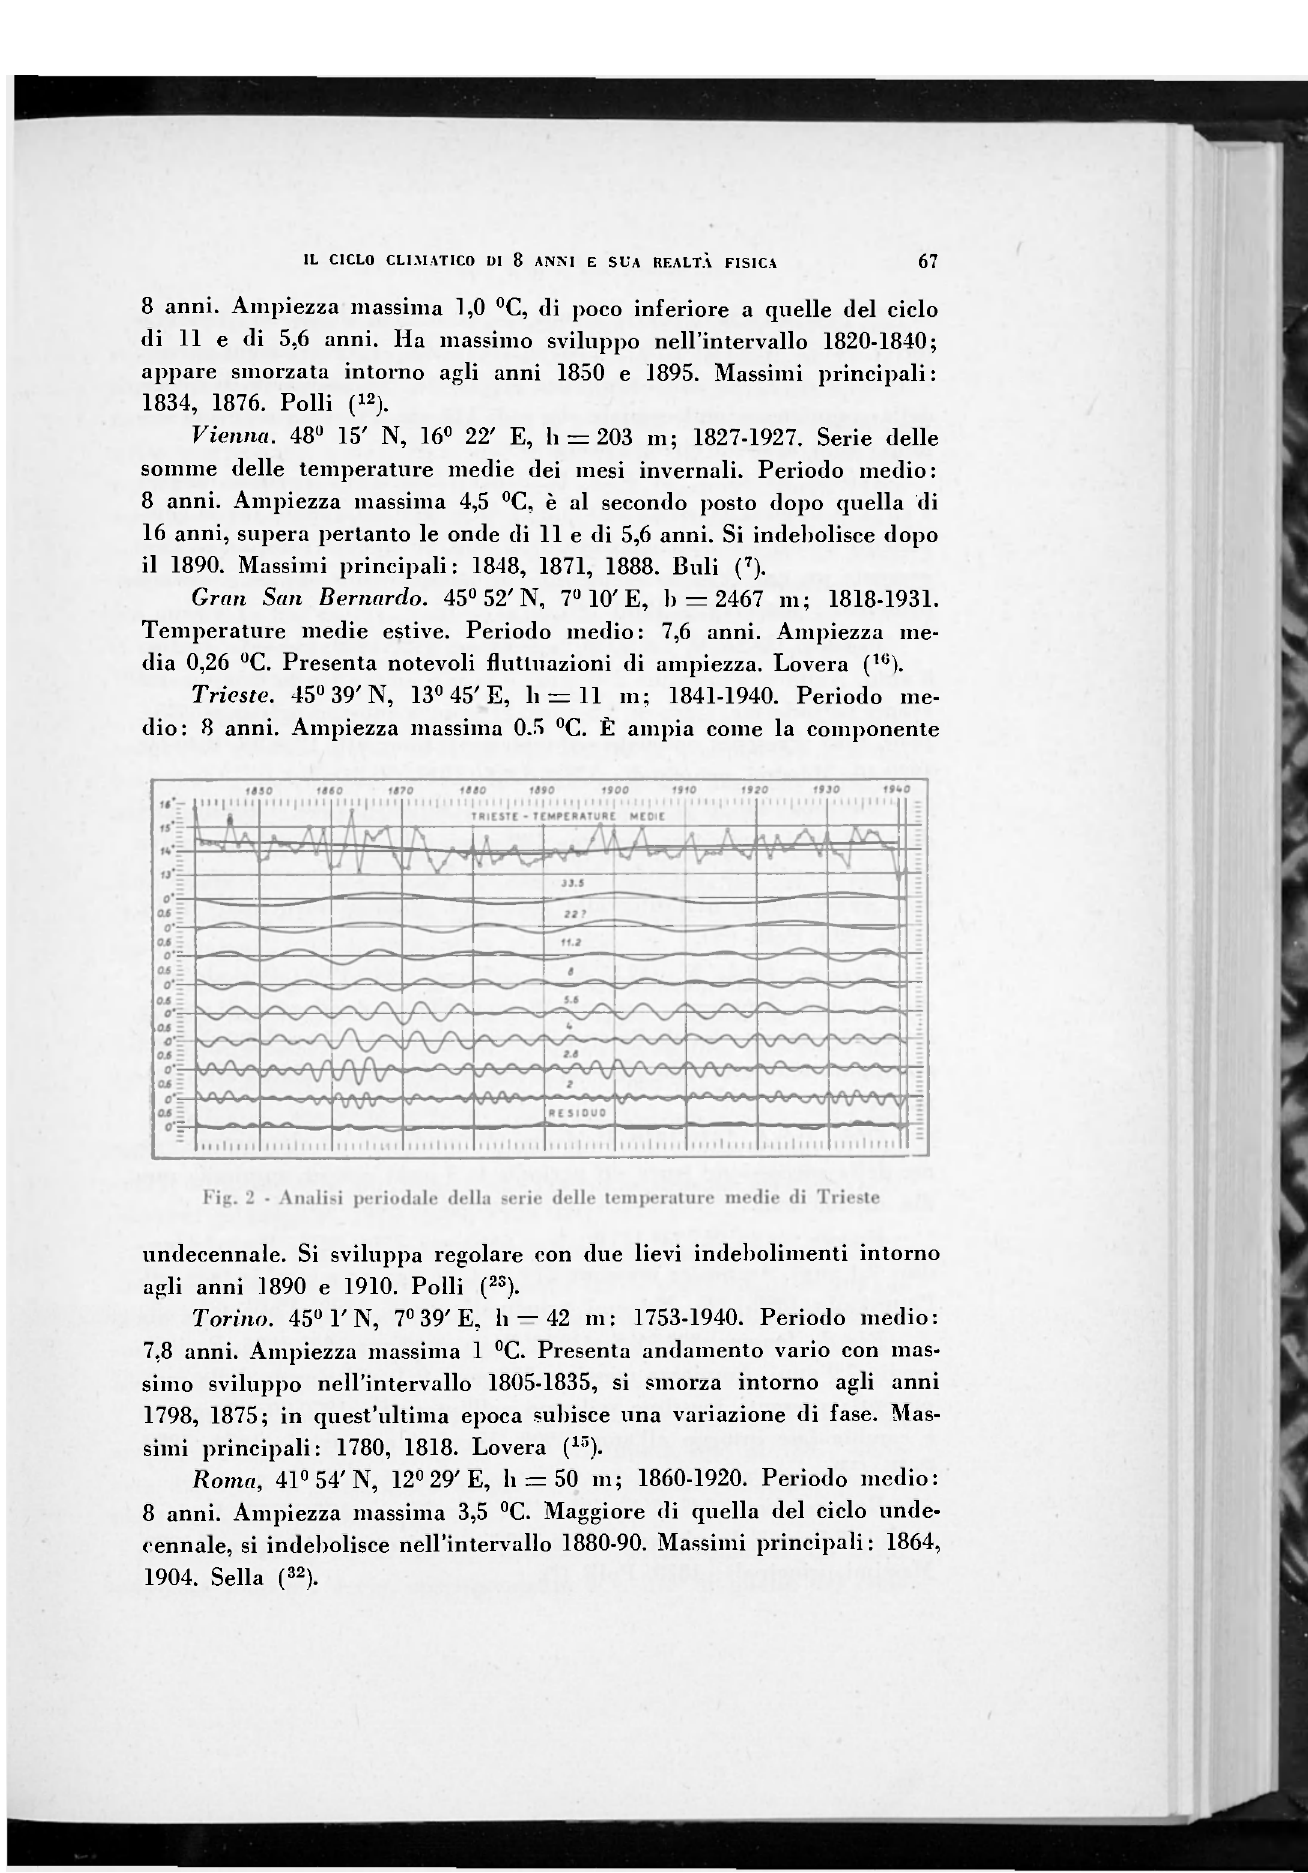
undecennale. Si sviluppa regolare con due lievi indebolimenti intorno agli anni 1890 e 1910. Polli ( 23